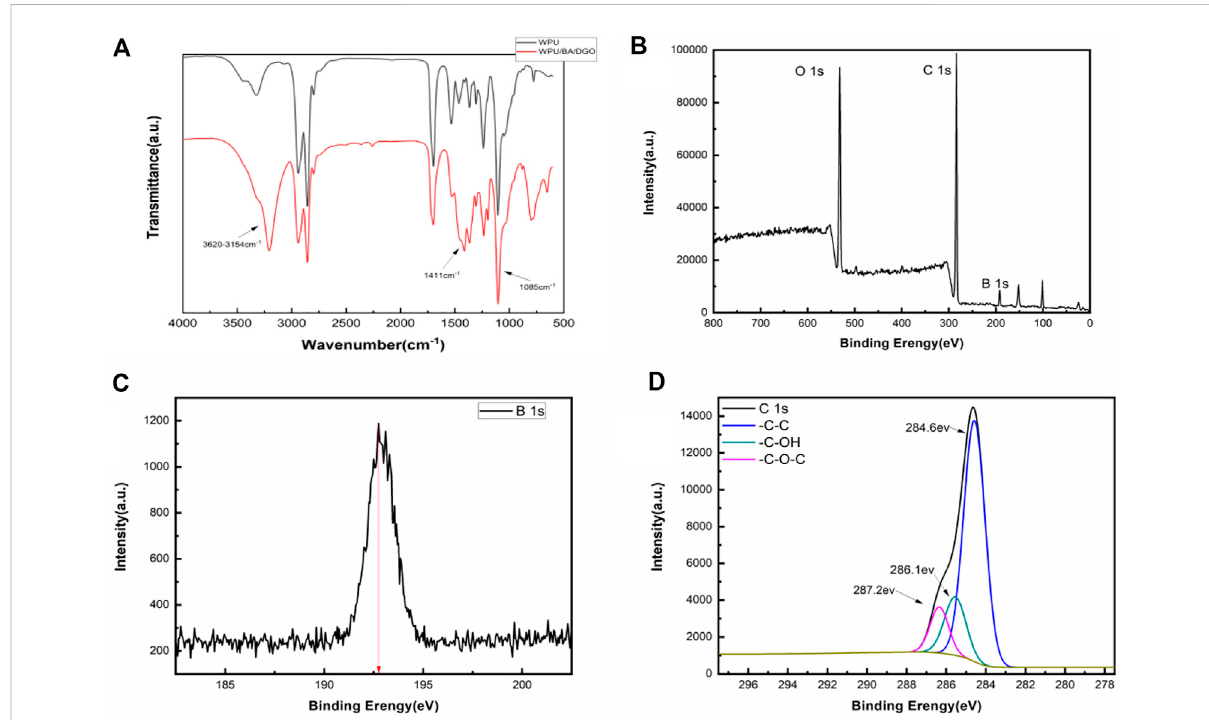
FIGURE 4 (A) FT-IR spectra of WPU and WPU/BA/DGO, (B) XPS spectra of WPU/BA/DGO, (C) XPS B1s spectra of WPU/BA/DGO, (D) XPS C1s spectra of